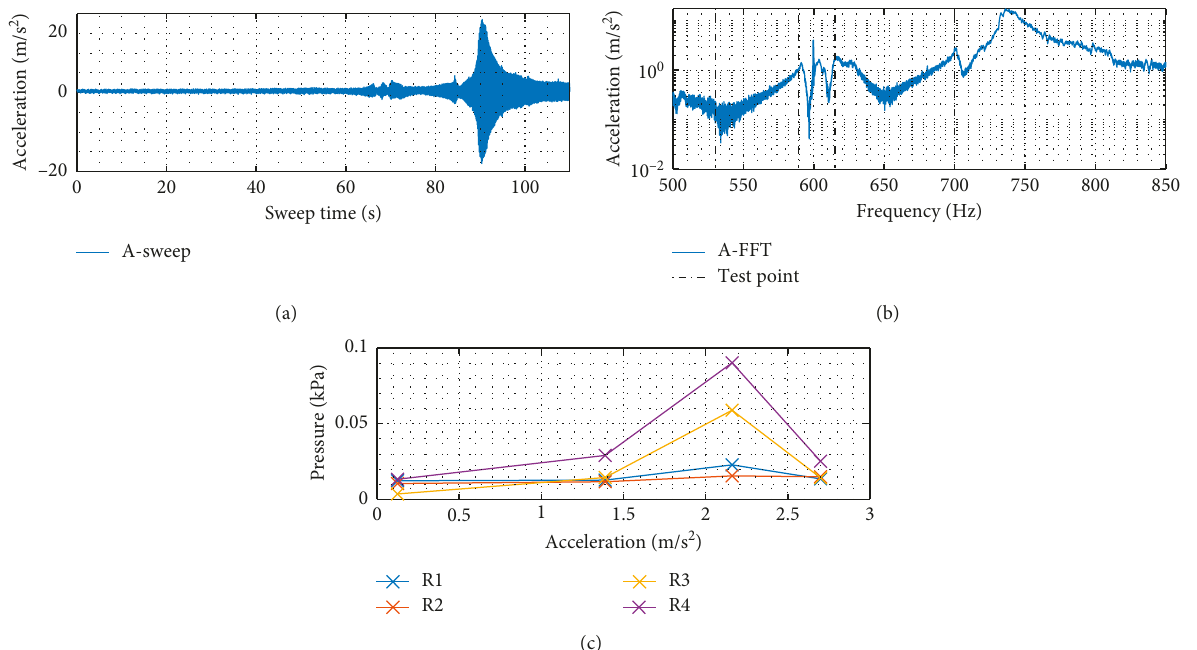
Figure 8: Vibration sensitivity test of the pressure sensors. The runner was excited in air with a frequency sweep with an unbalanced mass shaker. Four test points were repeated with constant frequency. The response was measured with the accelerometer and the pressure